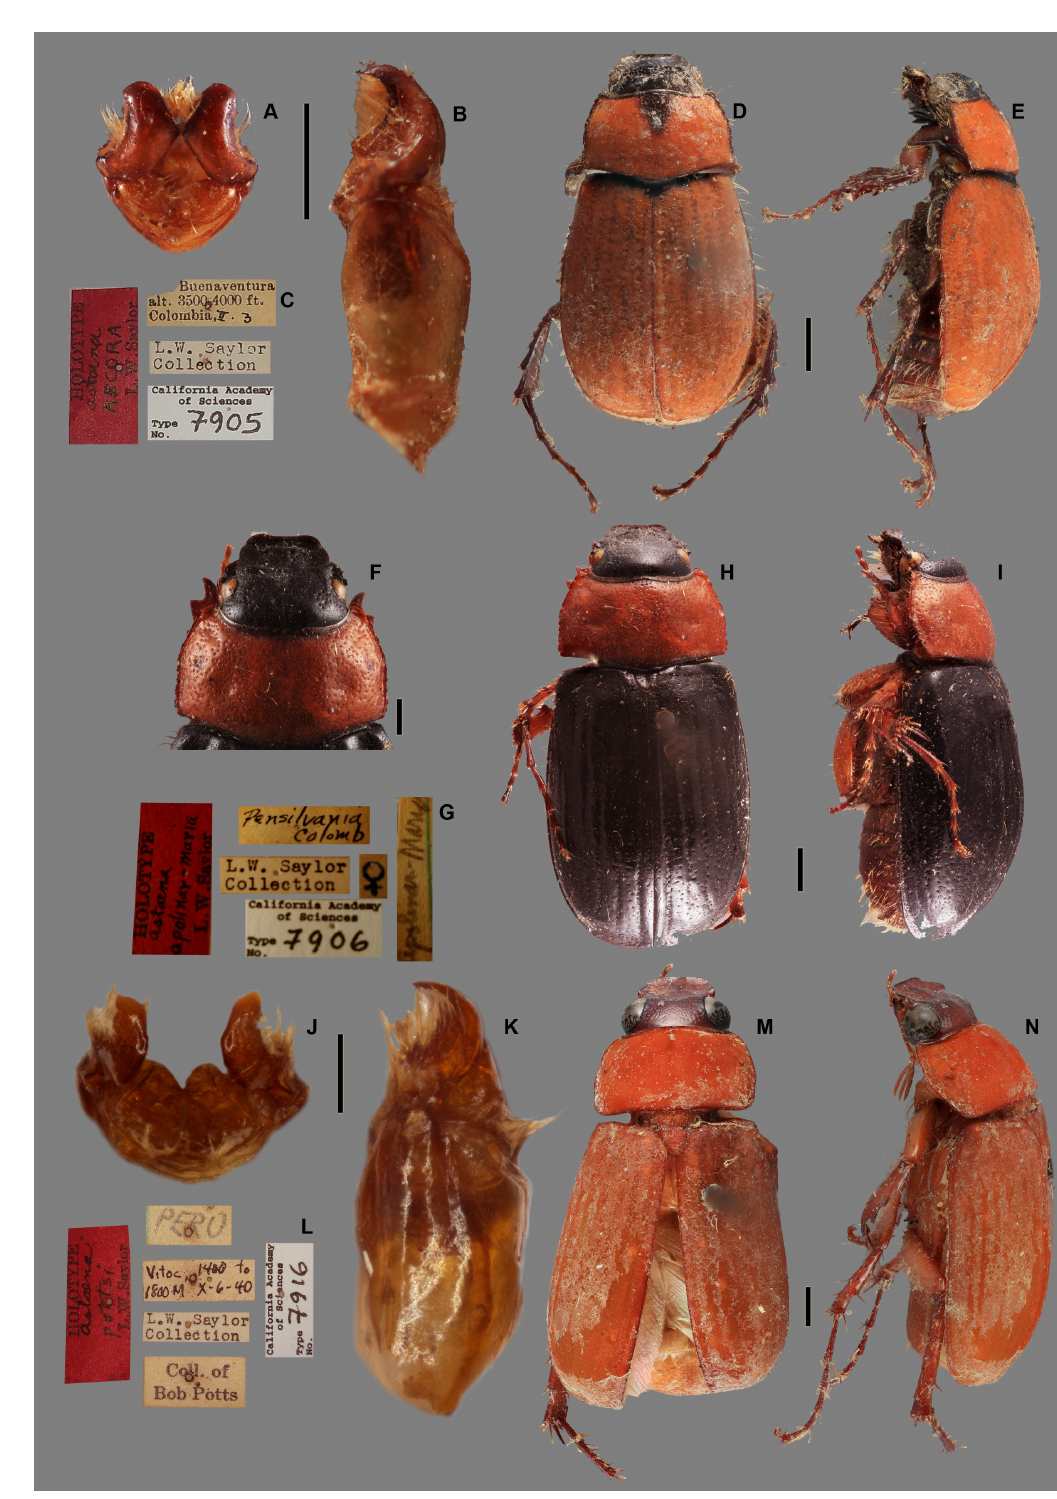
Fig. 6. A–E . Sayloria abcora (Saylor, 1946), holotype, ♂ (Type No. 7905; CAS). – F–I . Astaena apolinarmaria Saylor, 1946, holotype, ♀ (Type No. 7906; CAS). – J–K . Sayloria pottsi (Saylor, 1946), paratype, ♂ (CAS). – L–N . S. pottsi , holotype, ♀ (Type No. 7916; CAS). A, J . Parameres, dorsal view. B, K . Aedeagus, lateral view. C, G, L . Labels. D, H, M . Habitus, dorsal view. E, I, N . Habitus, lateral view. F . Head and pronotum, dorsal view. Scale bars: A–B, F, J–K = 0.5 mm; D–E, H–I, M–N = 1